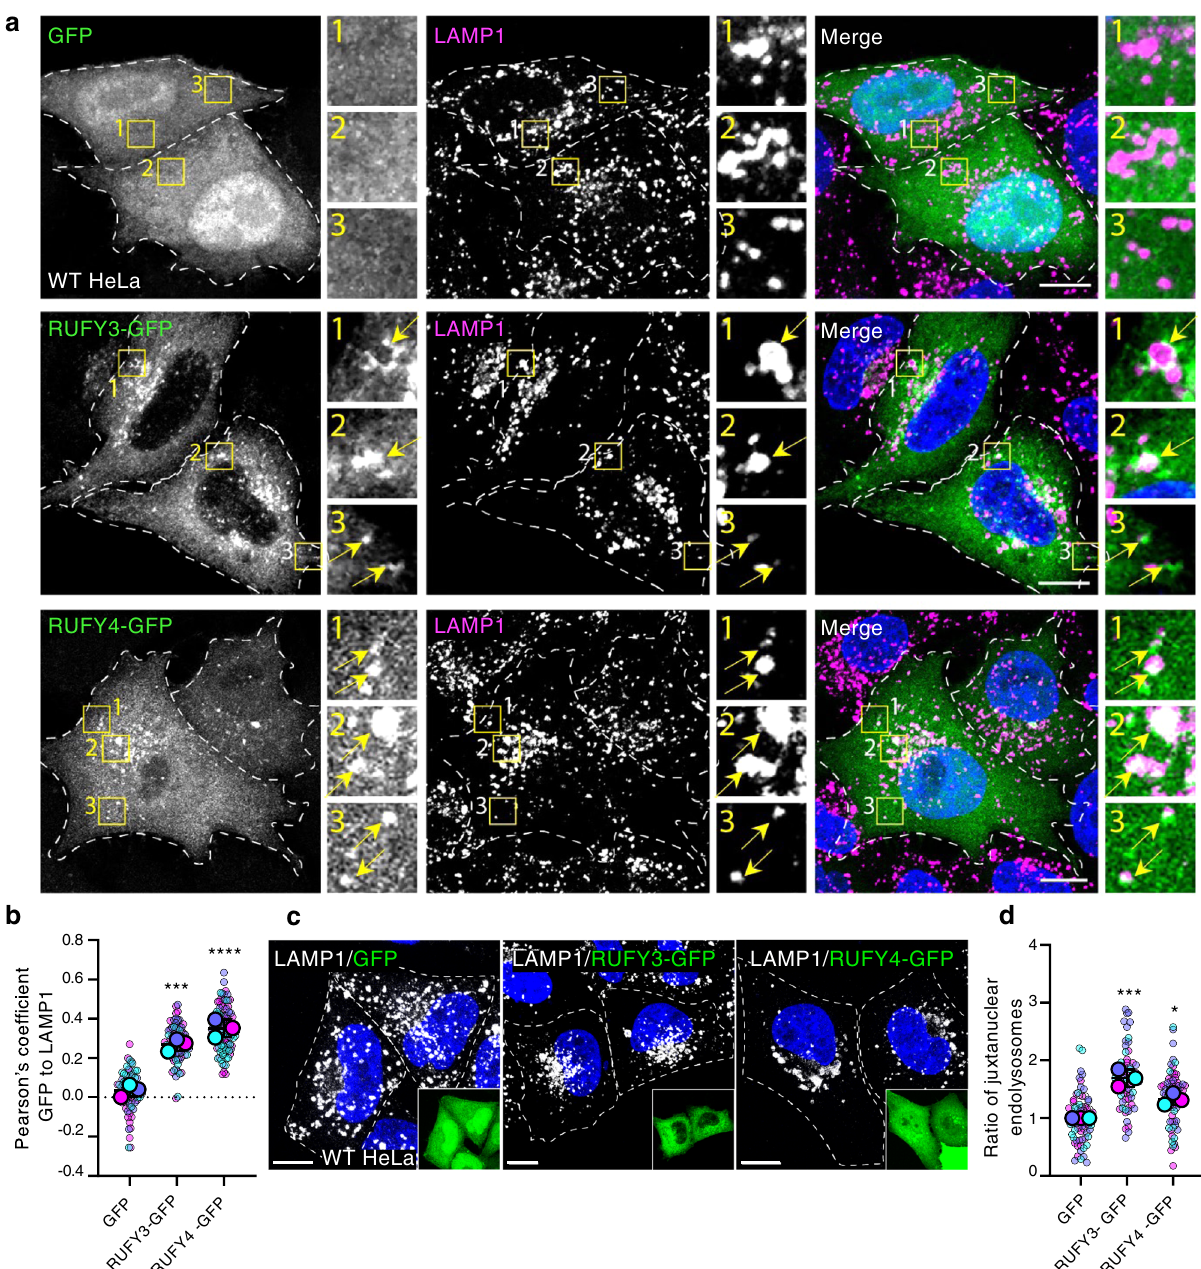
Fig. 4 RUFY3 and RUFY4 localize to endolysosomes, and promote their juxtanuclear clustering. a Co-localization of RUFY3-GFP and RUFY4-GFP with endogenous LAMP1. Immuno fl uorescence microscopy of HeLa cells transfected with plasmids expressing GFP (control), RUFY3-GFP or RUFY4-GFP (green), fi xed and immunostained for endogenous LAMP1 (magenta). Nuclei were stained with DAPI (blue). Cells with low-to-moderate expression of RUFY3-GFP or RUFY4-GFP were selected for analysis of co-localization. Single channels are shown in grayscale. Cell edges are shown with dashed lines. Scale bars: 10 μ m. Insets show 3-fold enlargements of the boxed areas. Arrows indicate vesicles where RUFY3/4-GFP proteins co-localize with LAMP1. b SuperPlot representation of the Pearson ’ s correlation coef fi cient for the co-localization of GFP, RUFY3-GFP or RUFY4-GFP with endogenous LAMP1 from experiments such as that shown in panel ( a ). Values were calculated and represented as described for Fig. 3c. Horizontal lines indicate the mean ± SD of the means from three independent experiments. Statistical signi fi cance was calculated using one-way ANOVA with multiple comparisons to the GFP control using Dunnett ’ s test. *** p < 0.001, **** p < 0.0001. c Overexpression of RUFY3-GFP or RUFY4-GFP causes juxtanuclear clustering of endolysosomes. This experiment was done as described for panel ( a ), except that highly overexpressing cells were chosen for analysis. Endogenous LAMP1 staining is shown in grayscale and GFP images in green (inset). The strong cytosolic staining of the GFP constructs is due to the overexpression. Nuclei were stained with DAPI (blue). Cell edges are highlighted with dashed lines. Scale bars: 10 μ m. Insets show 2.85-fold reductions of the transfected cells. d SuperPlot representation of the ratio of juxtanuclear LAMP1 to total LAMP1 calculated by shell analysis from experiments such as those in panel ( c ). Values were calculated and represented as described for Fig. 3c, h. Horizontal lines indicate the mean ± SD of the means from three independent experiments. Statistical signi fi cance was calculated using one-way ANOVA with multiple comparison to the GFP control using Dunnett ’ s test. * p < 0.05, *** p <